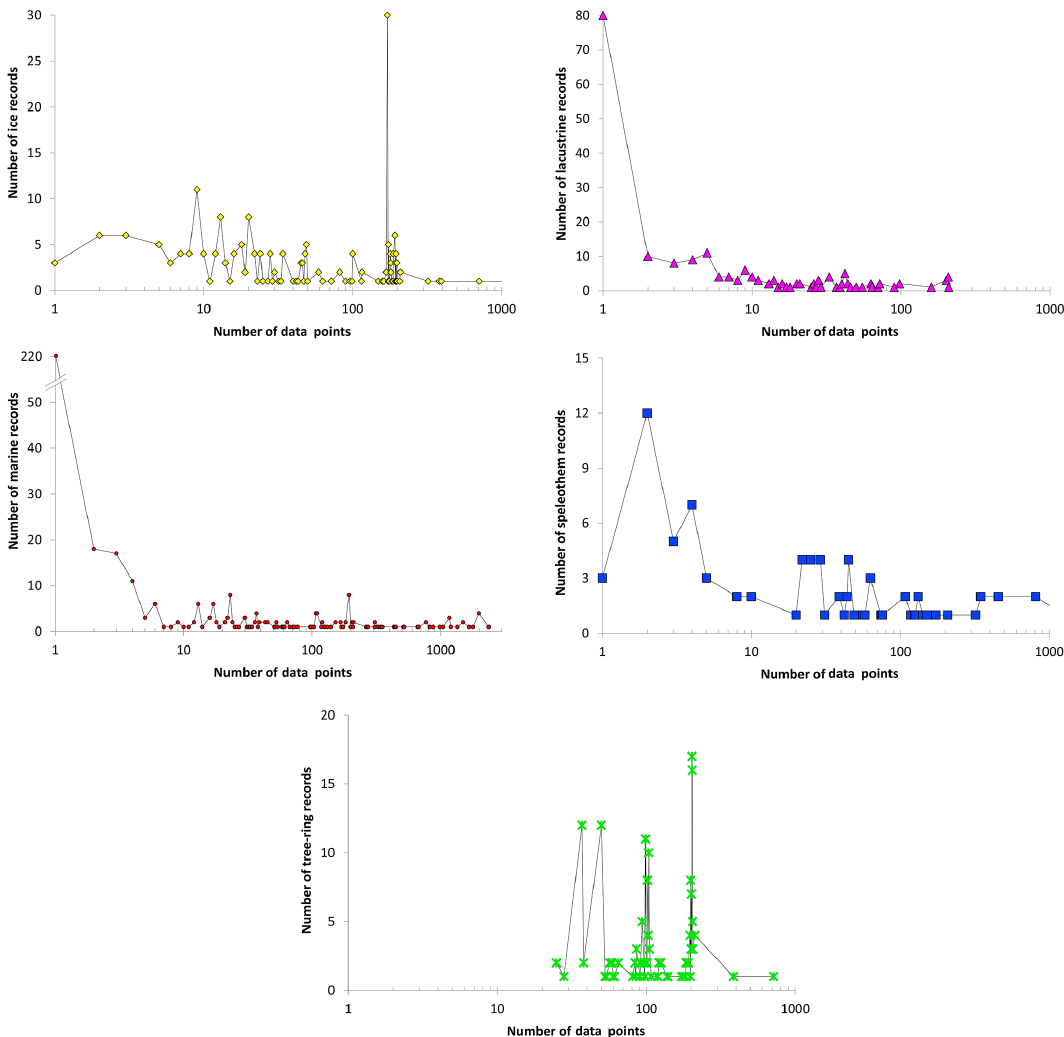
Figure A1. Diagrams showing the distribution of records (number of records) as a function of their mean time resolution (number of data points) for the different types of archives compiled in the database for the present day (1800–2013CE). Note the different vertical